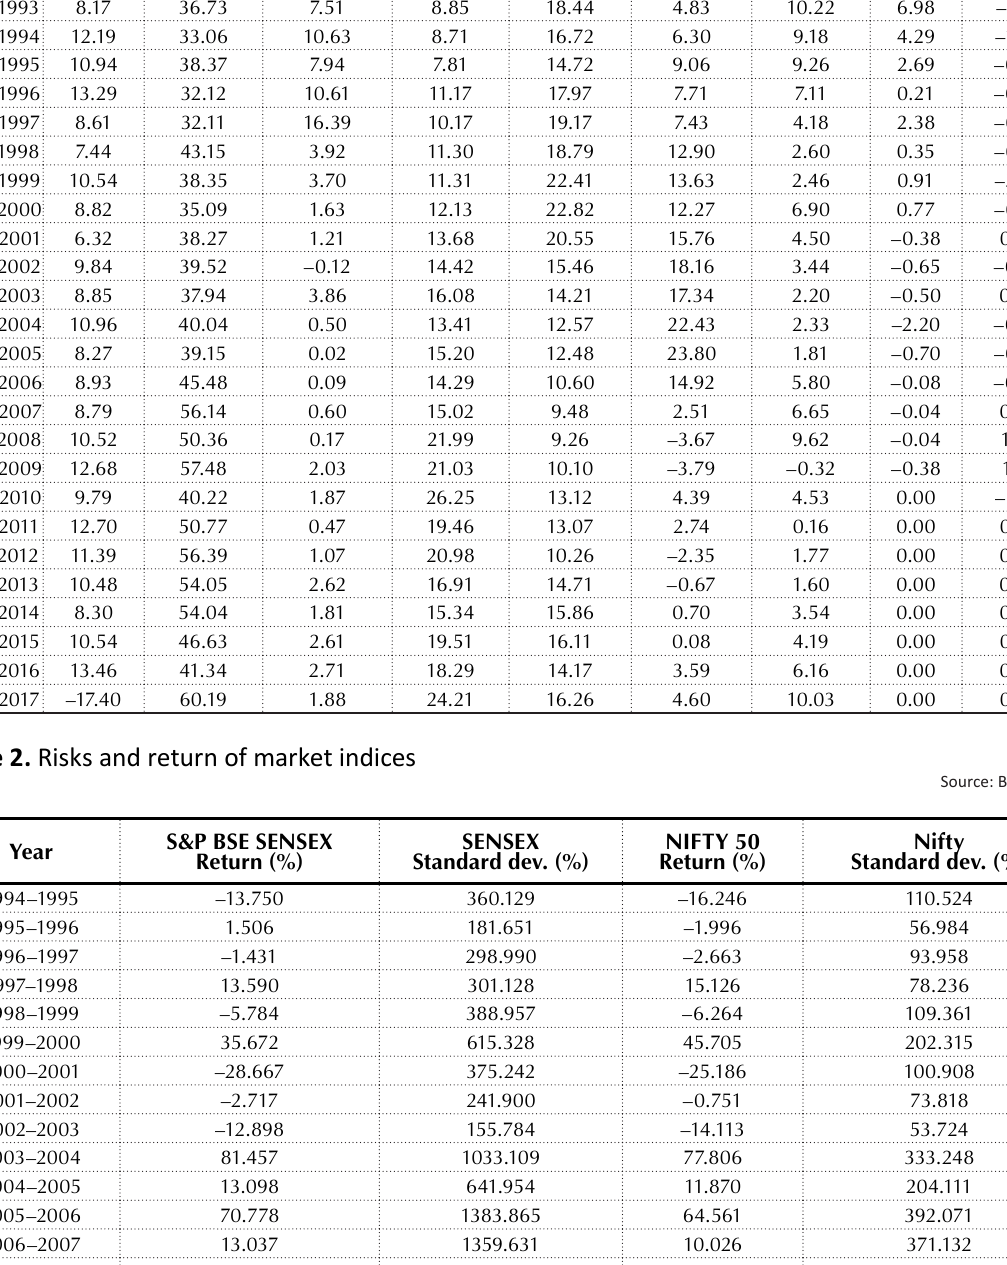
Table 1. Changes in financial assets of the household (in %)